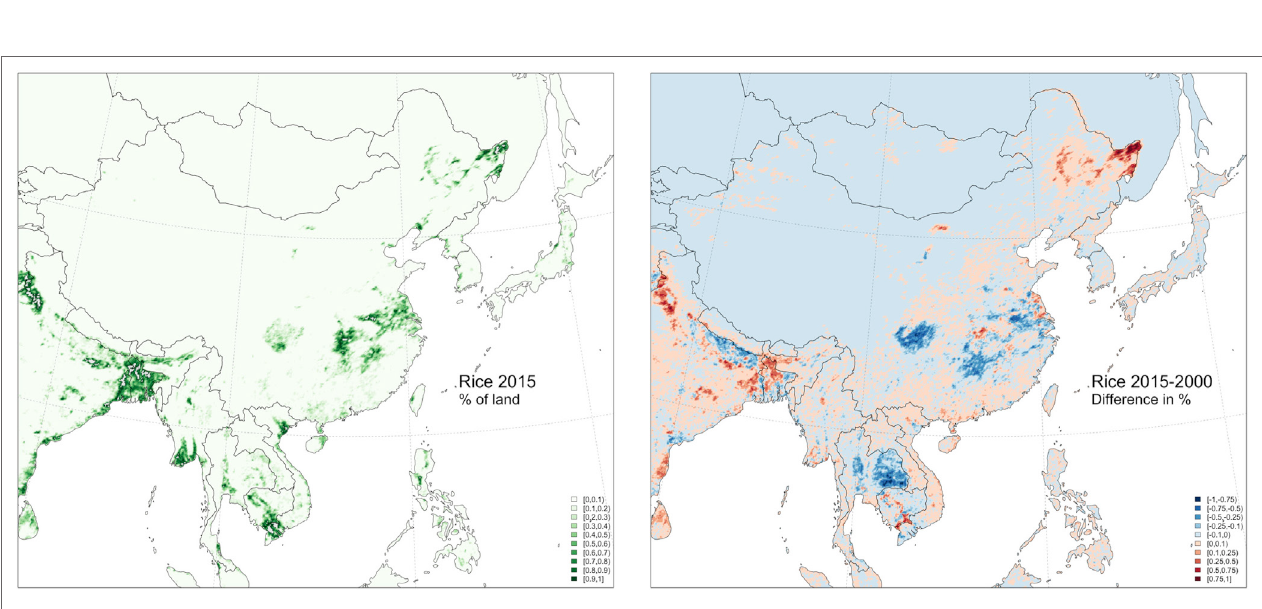
Figure 4 | Distribution of rice harvest in 2015 (left) and % difference between the surface harvested in 2015 and 2000 at 5 km × 5 km grid cells, according to Zhang et al. (21).